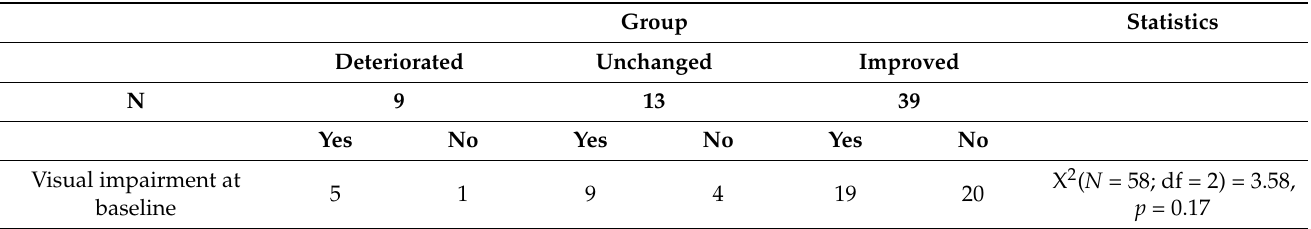
Table 4. Distribution of visual impairments at baseline, separately for the three groups of improving ( n = 39), unchanged ( n = 13), and deteriorating ( n = 6). Group Statistics Deteriorated Unchanged